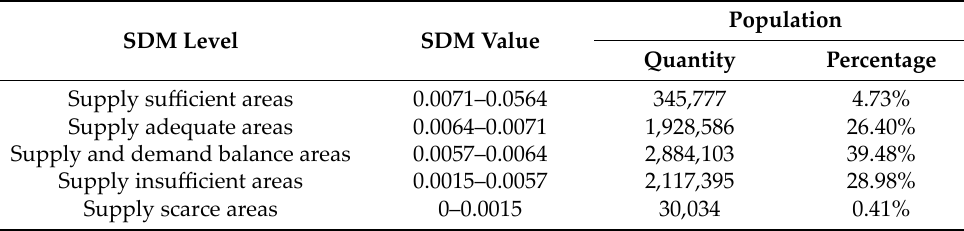
Figure 7. Schematic diagram of SDM assessment of public medical health resources in the research area. Table 4. Hierarchical statistics of SDM of public medical health resources in central Tianjin.